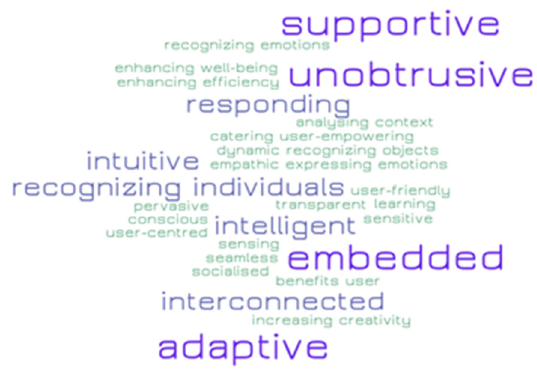
Figure 1. Attributes and characteristics of intelligent environments.